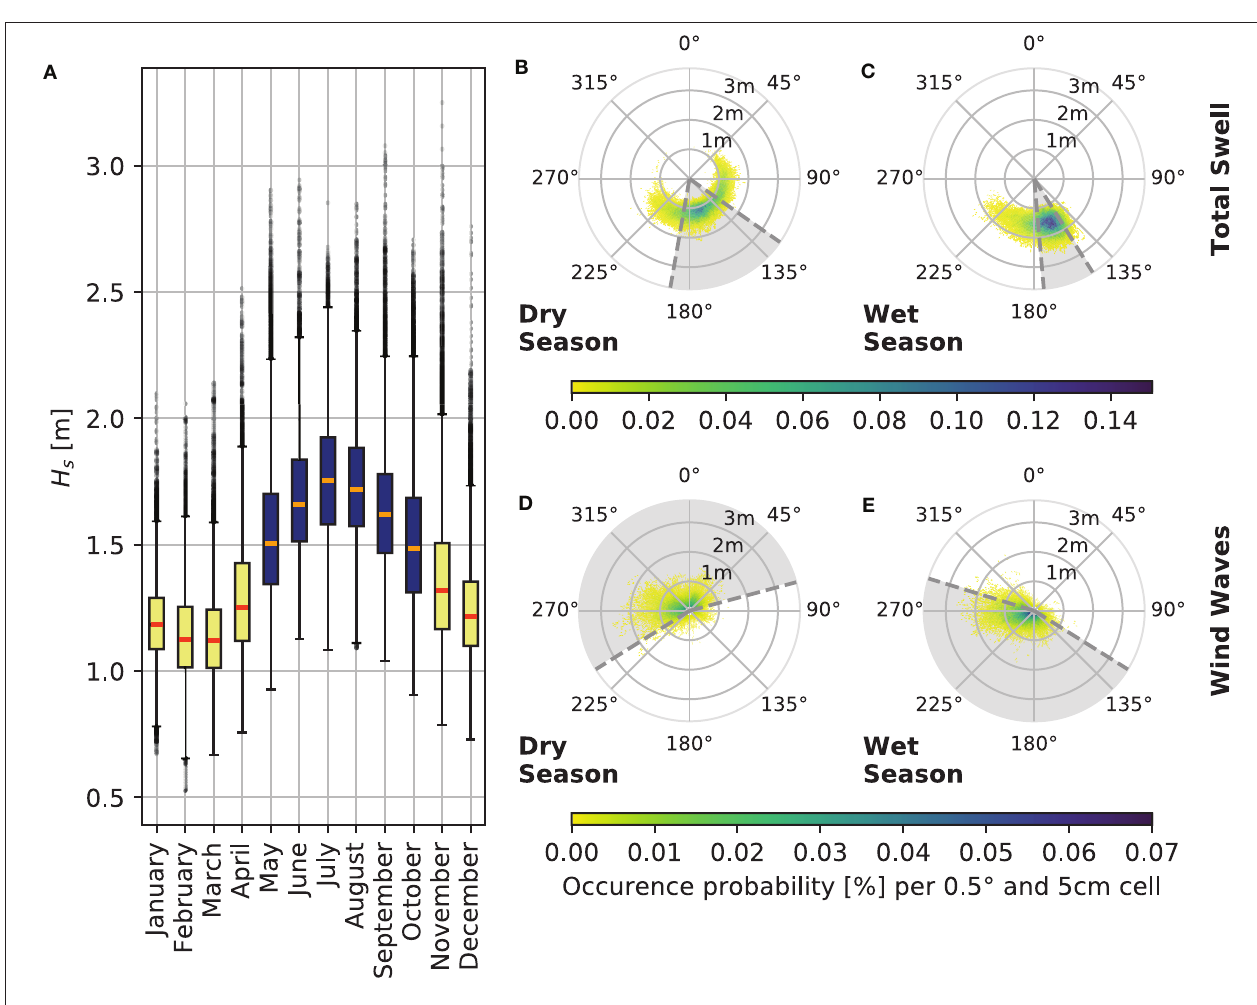
FIGURE 2 | Wave climate at the ERA5 data node ( Figure 1 ) (A) Shows monthly box plots of hourly significant wave height H s for a time series from 1979 to 2019. Here, blue boxes are wet season months and yellow boxes are dry season months. (B) Shows the discrete marginal distribution between the peak wave direction θ p and the significant wave height H s of the dry season, while (C) contains this information for the wet season. Both plots use only swell data, while (D,E) contain the same information for wind waves. Here, the colorbar shows the occurrence probability of each 0.5 ◦ wave direction and 0.05m wave height cell. The gray areas visualize the significant peak direction range θ p , sig for each subset, containing the directions which combined have the highest 33% occurrence